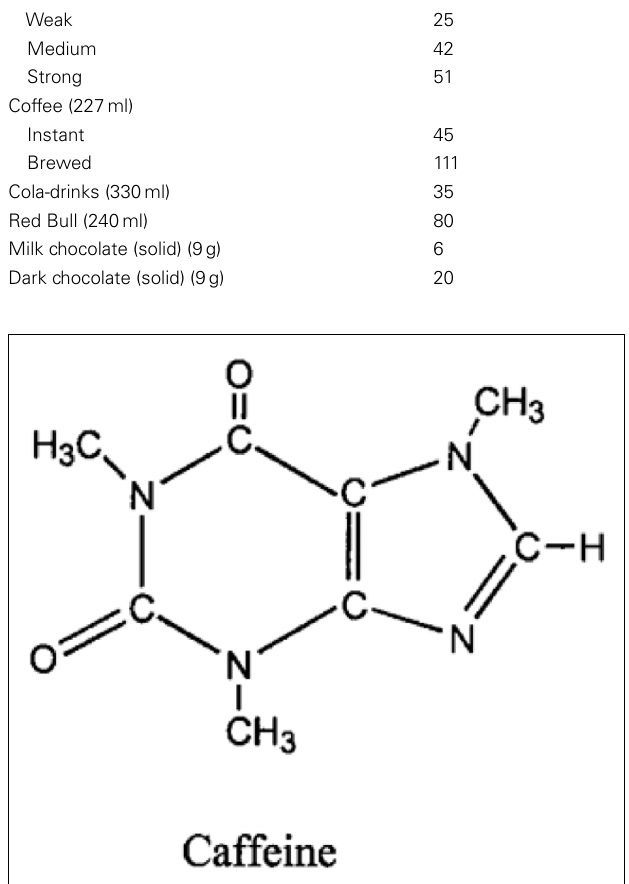
FIGURE 1 | Chemical structure of caffeine (Deng et al.,